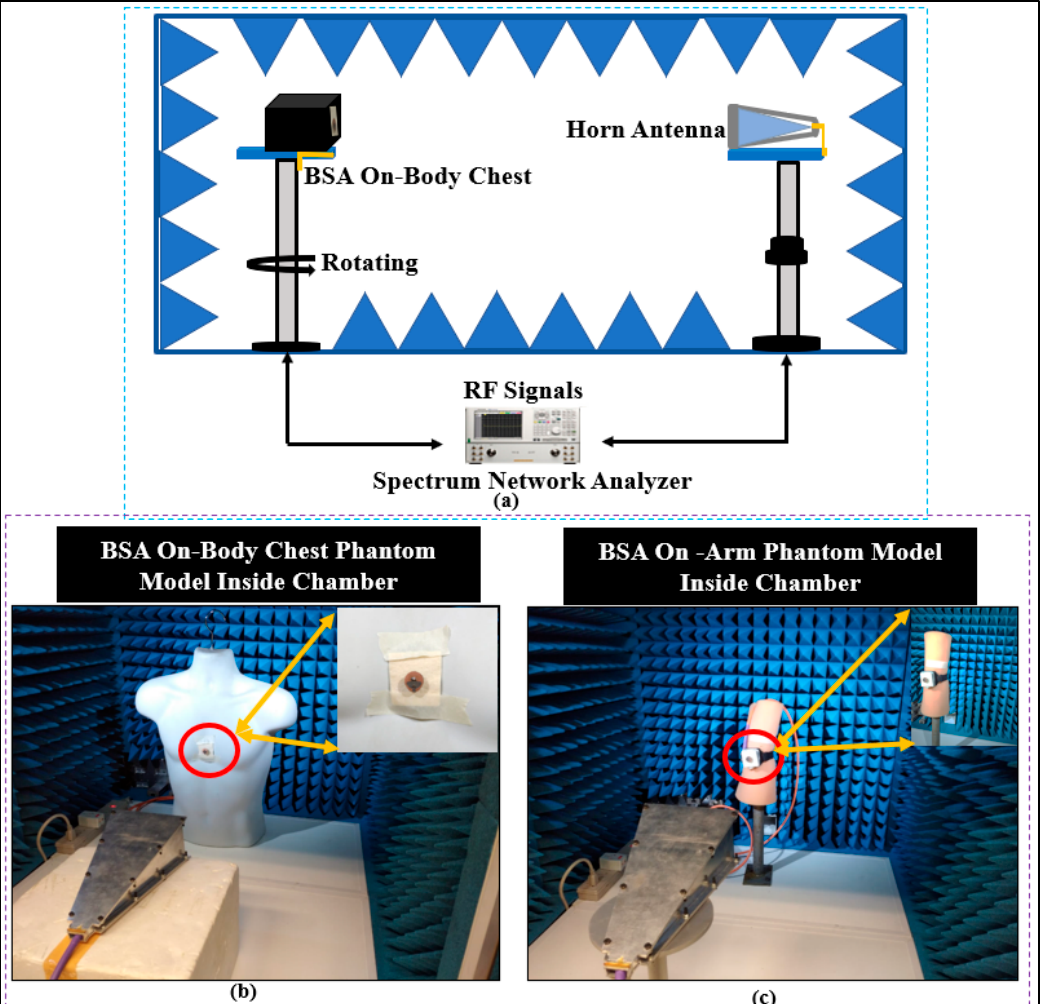
Figure 23. ( a ) Setup for far-field measurement, ( b ) phantom for the chest position, and ( c ) phantom for the arm